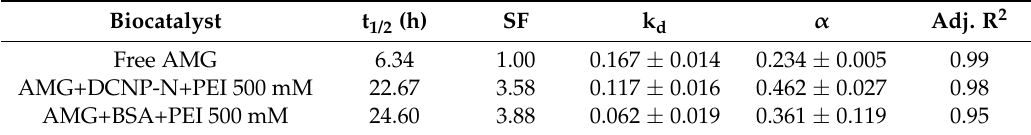
Table 4. Half-life times (t 1/2 ) and stability factor (SF) for amyloglucosidase (free and immobilized AMG) at 55 ◦ C and pH 4.5.